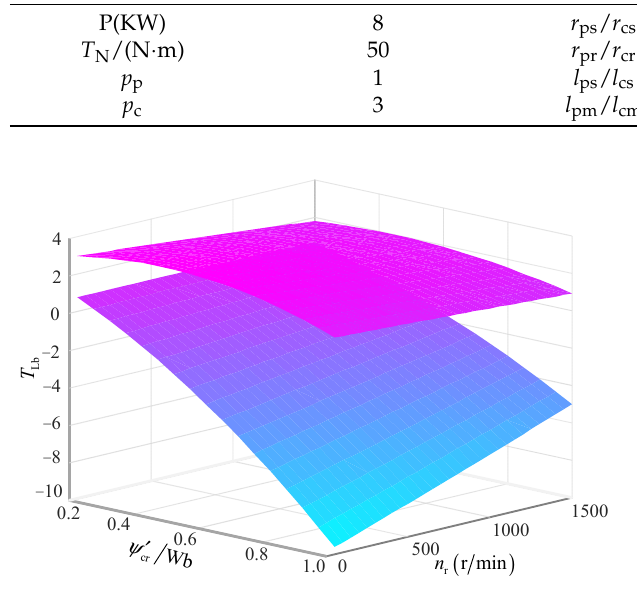
Figure 5. The boundaries of load torque.